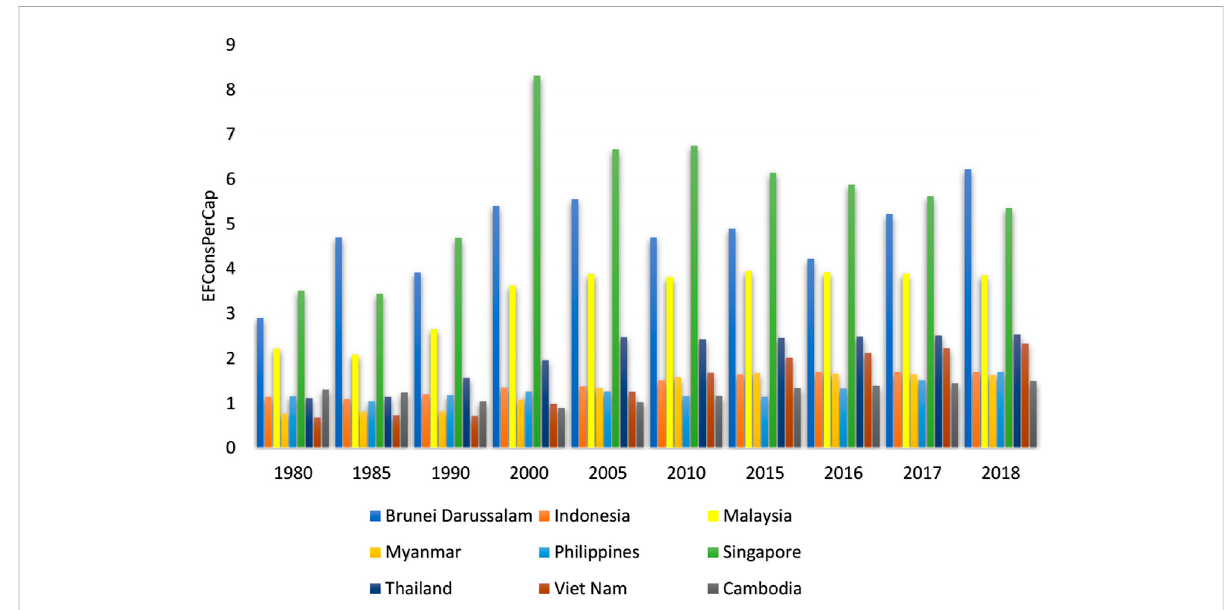
FIGURE 1 EFP (constant per capita) for ASEAN economies Source: Visuals drawn by authors, data from